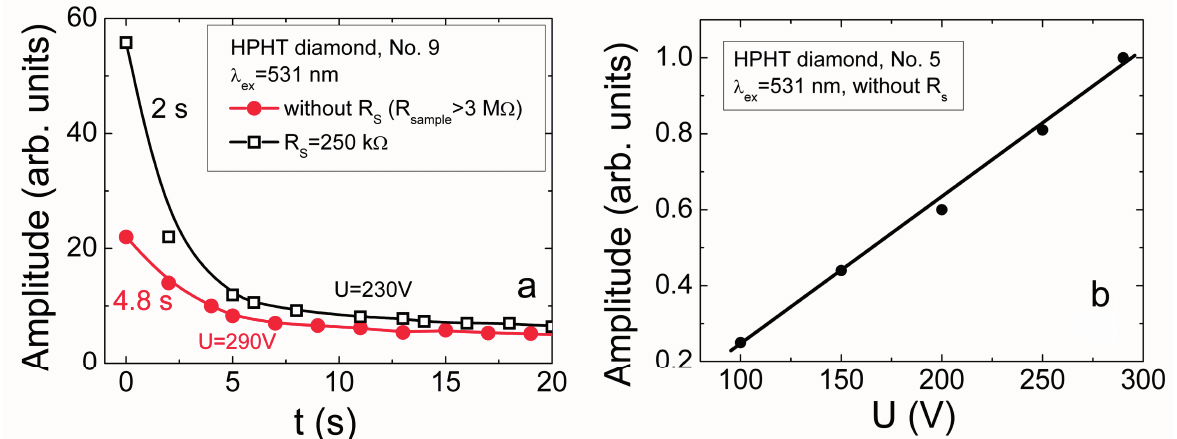
Figure 8. ( a ) Evolution of the current peak amplitude just after sharp switch-on a voltage of 290 V without (solid symbols) and with (hollow symbols) shunt resistance, measured in capacitor type detector made of HPHT diamond; ( b ) The current peak amplitude as a function of applied voltage for the fixed excitation intensity. These characteristics were measured by using injection of bulk domain at excitation wavelength λ ex = 531